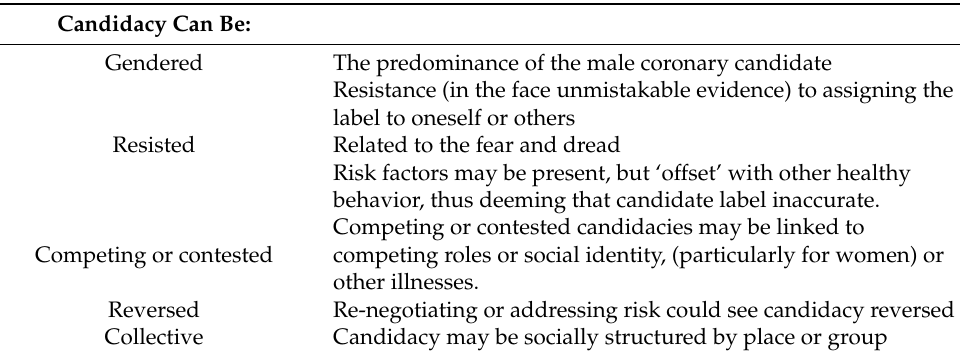
Table 2. Enactment of